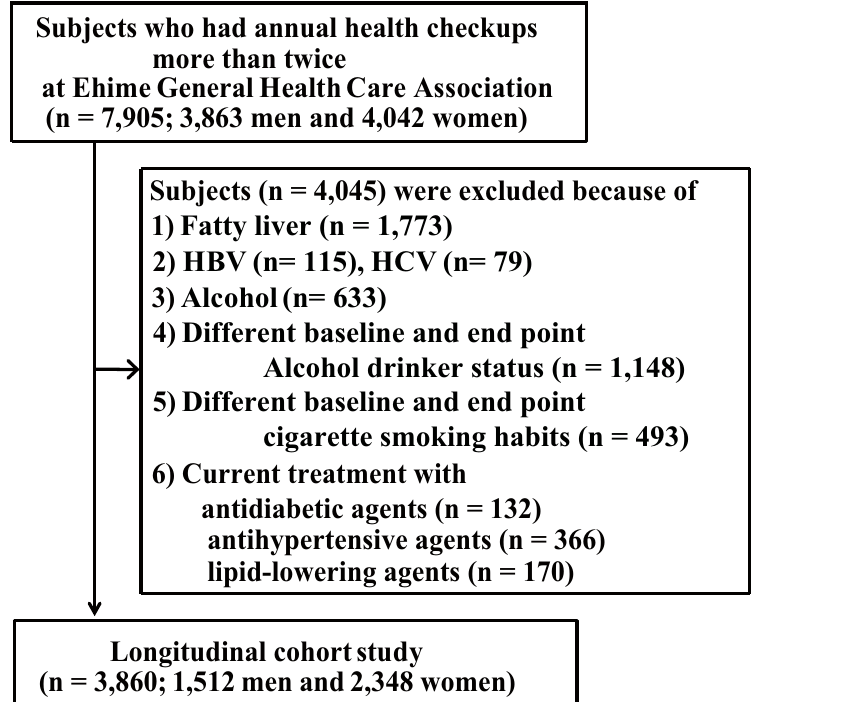
Fig 1. Flow chart of subject selection. Abbreviations: HBV, hepatitis B virus; HCV, hepatitis C virus.